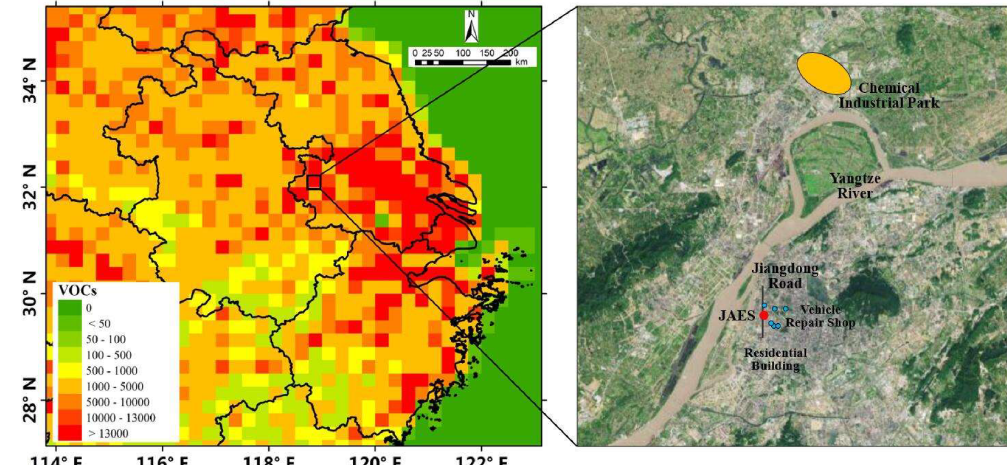
Figure 1. (a) Maps of the study location showing VOC emissions at a resolution of 0.25 ◦ (Mga − 1 ). (The data were taken from the MEIC emission inventory; http://www.meicmodel.org, last access: 15 September 2019.) (b) The location of the JAES sampling site is indicated by a red circle (the base map is from © Baidu Maps). The blue circles indicate vehicle repair shops, the yellow circle indicates chemical industry parks and the black solid line indicates a heavy-traffic